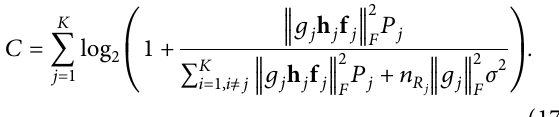
Figure 2: Diagram of power allocation for the multiuser precoding